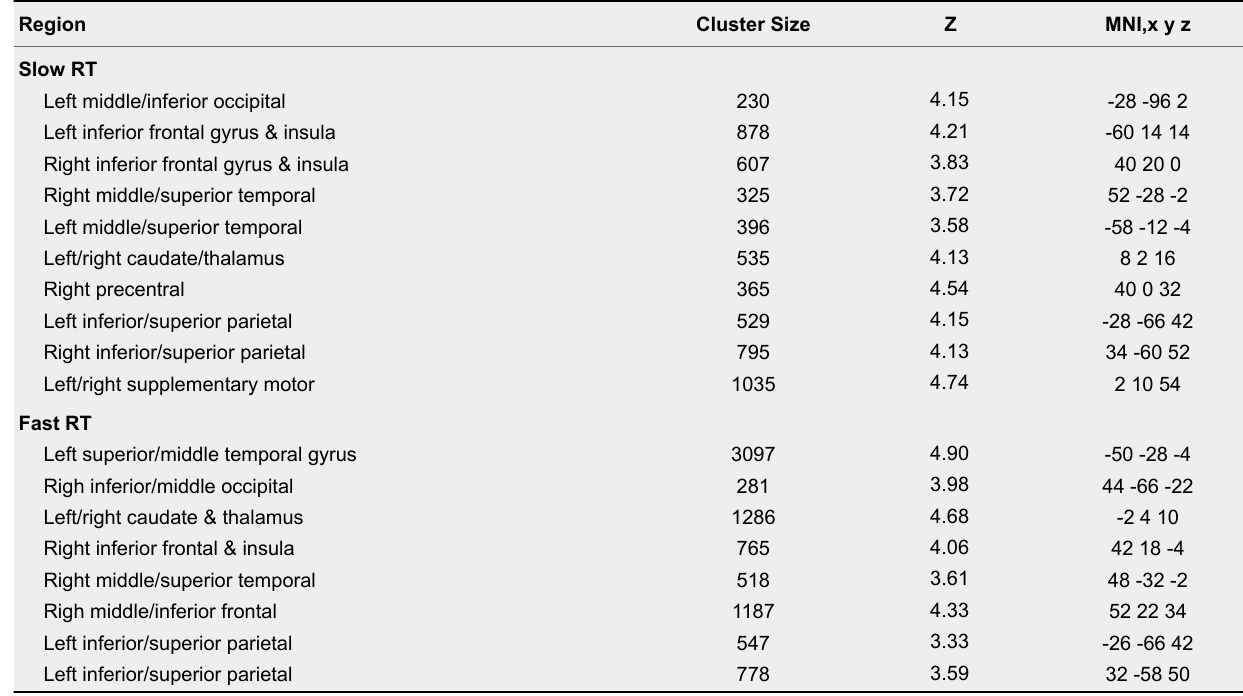
Summary of Activation for Each Condition Compared to